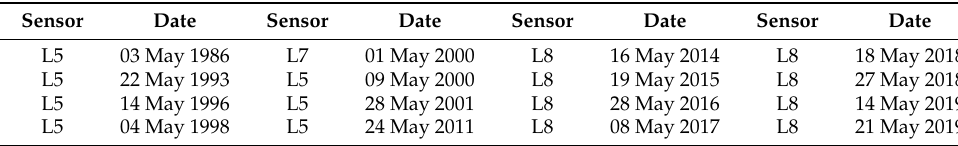
Table 1. Selected Landsat sensors and